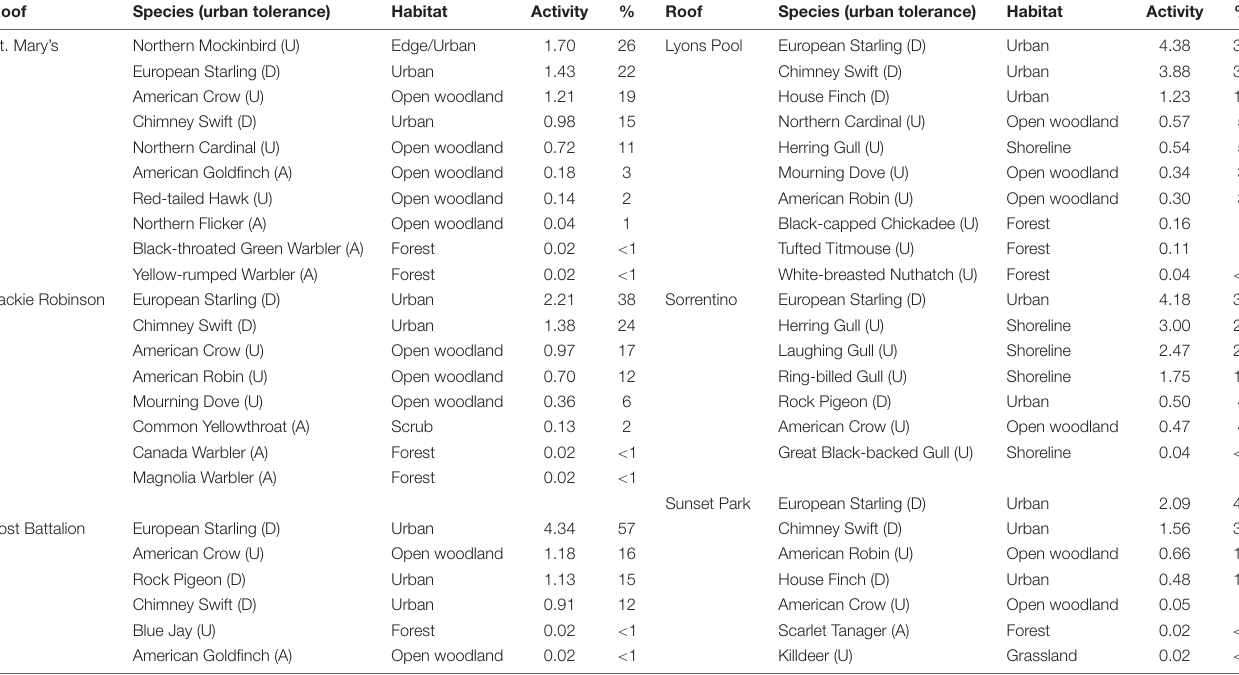
TABLE 2 | Bird species composition, activity (vocalizations/hour), and percent activity (percent of the total activity on each roof) on six New York City Department of Parks and Recreation recreation center roofs during May of 2010, 2011, 2012, and 2014.